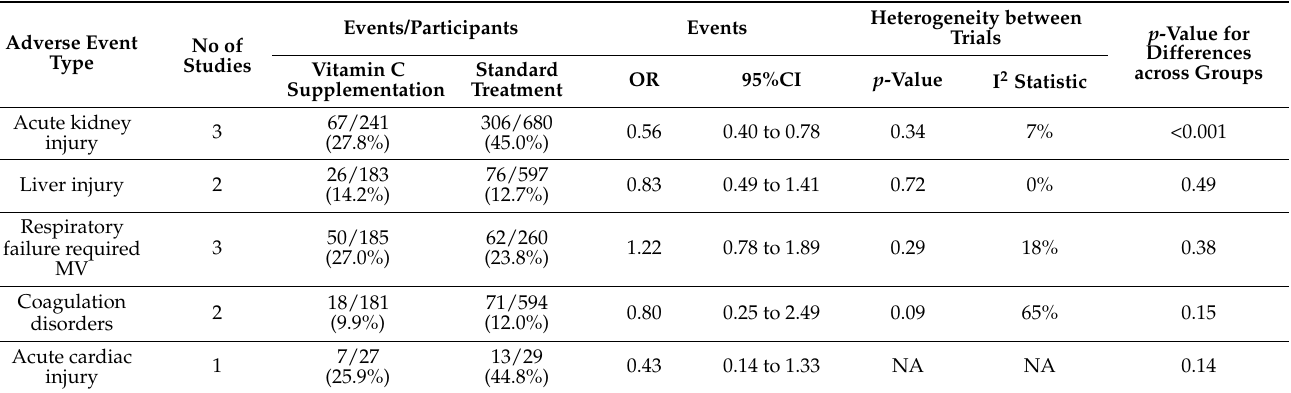
Table 2. Pooled analysis of adverse events.